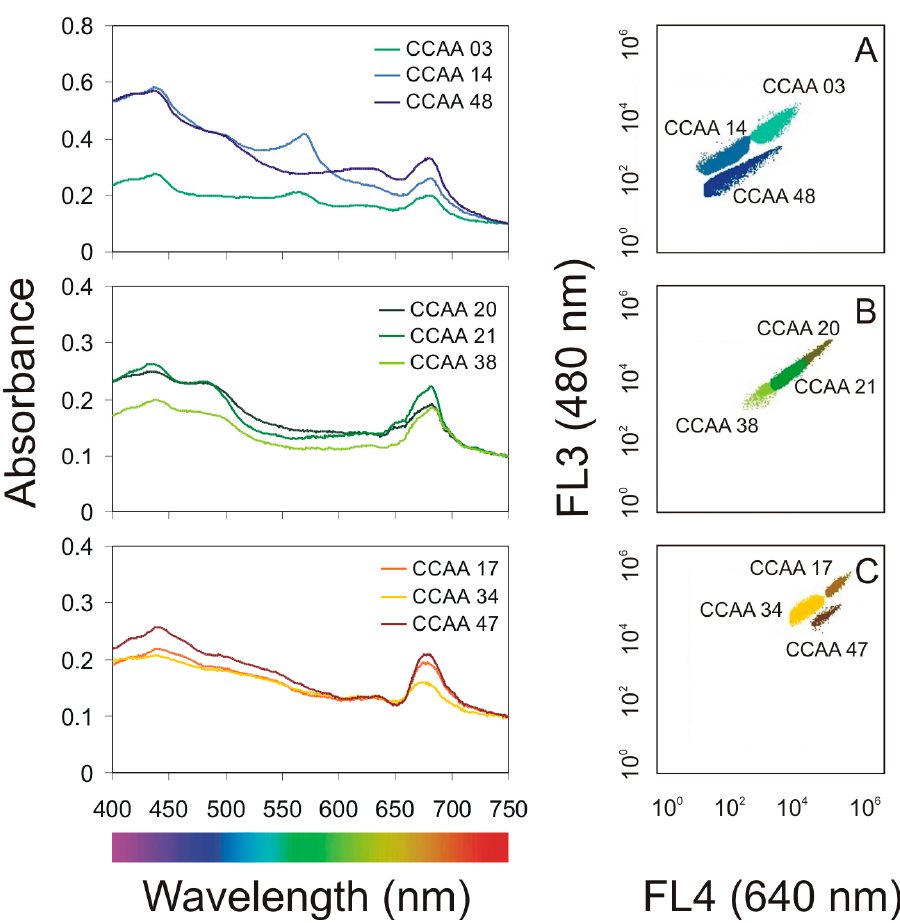
Figure 2. Left-hand panel—PAR absorbance spectra determined for the airborne cyanobacteria ( A ): Nostoc sp. (CCAA 03), Synechococcus sp. (CCAA 14), Aphanothece sp. (CCAA 48), green algae ( B ): Oocystis sp. (CCAA 20), Coccomyxa sp. (CCAA 21), Kirchneriella sp. (CCAA 38), and diatoms ( C ): Nitzschia sp. (CCAA 17), Amphora sp. (CCAA 34), Halamphora sp. (CCAA 47) at an optical density (OD 750 ) = 0.1; right-hand panel—cytograms obtained using a BD Accuri C6 Plus flow cytometer. FL3 detectors (red fluorescence) read fluorescence emissions excited by the blue laser (480 nm), whereas the FL4 detector (orange fluorescence) reads emissions excited by the red laser (640